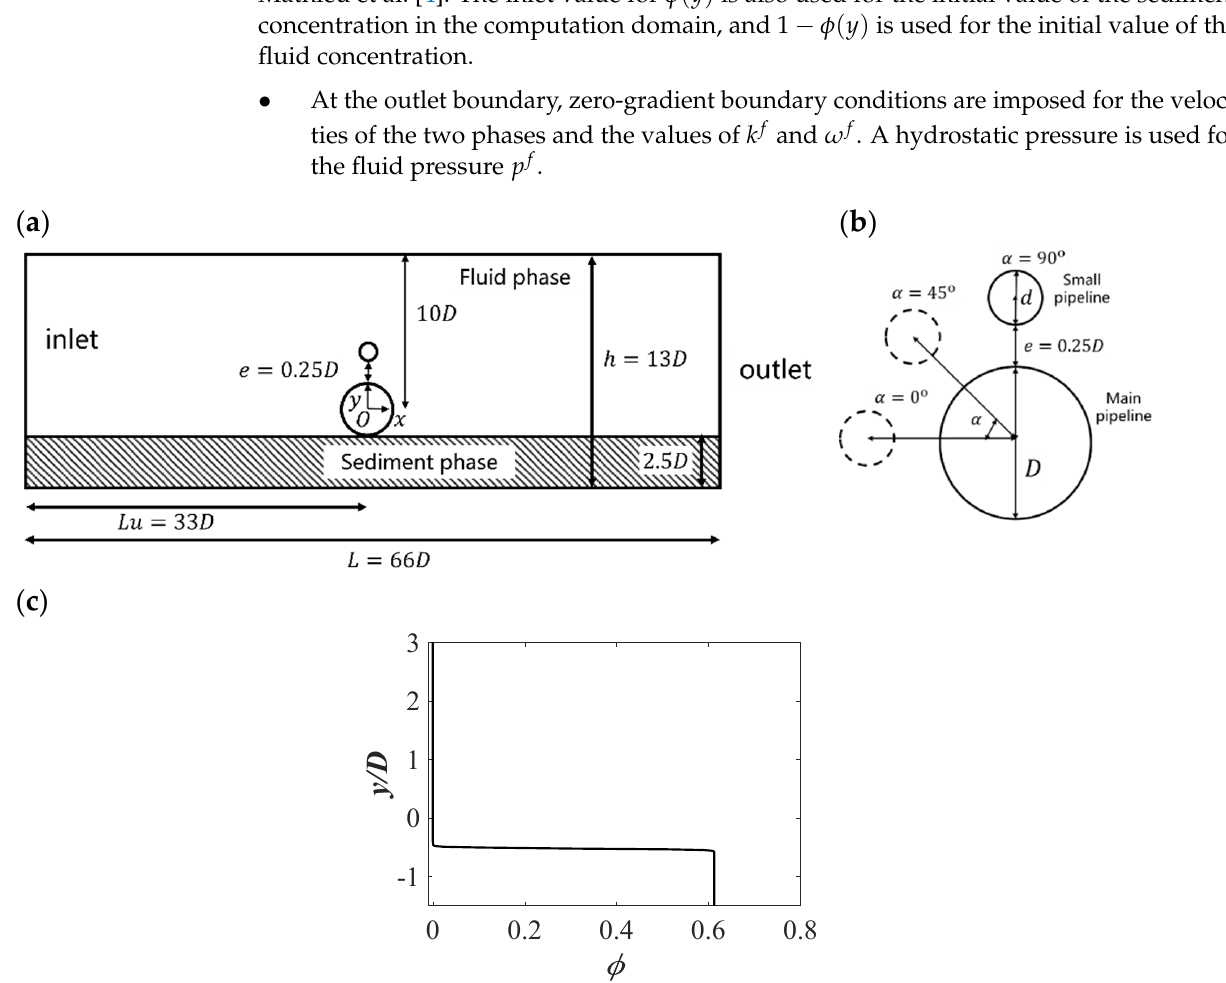
Figure 1. ( a ) Computational domain; ( b ) the configurations of the piggyback pipelines within the computational domain; ( c ) the profile of the sediment concentration φ ( y ) .